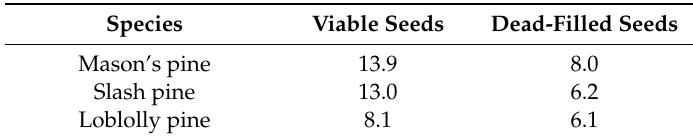
Table 1. The relative water content (%) of dead-filled and viable seeds of three pine species after incubation and drying for six